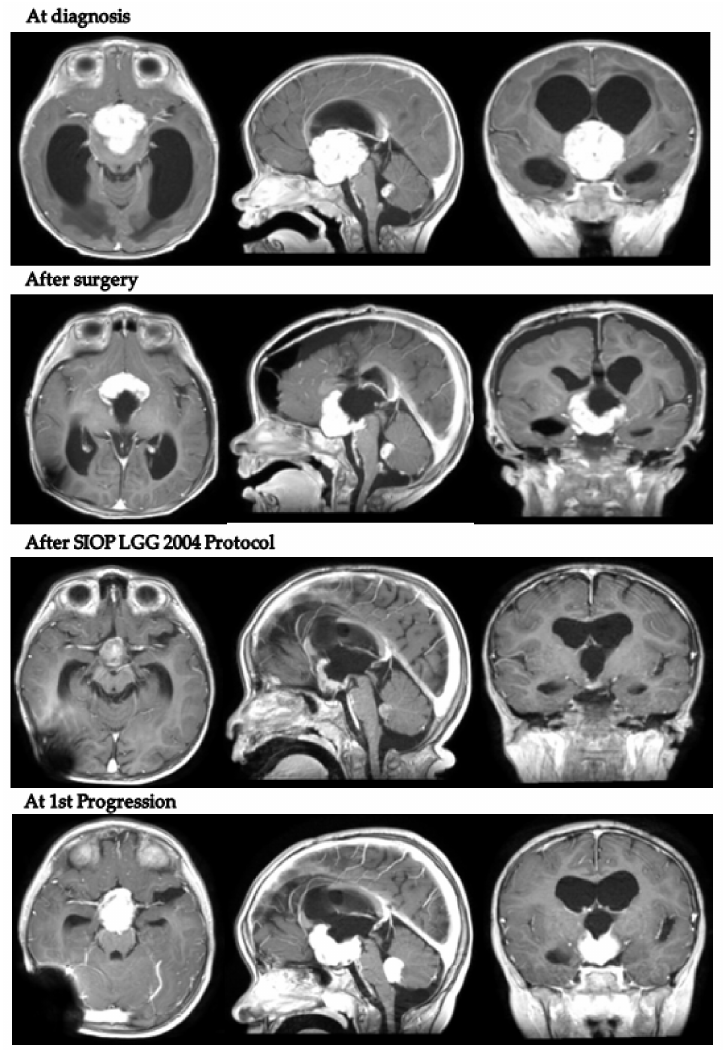
Figure 4. Patient 5 axial, coronal and sagittal post-contrast T1-weighted MRI scans at 4 different